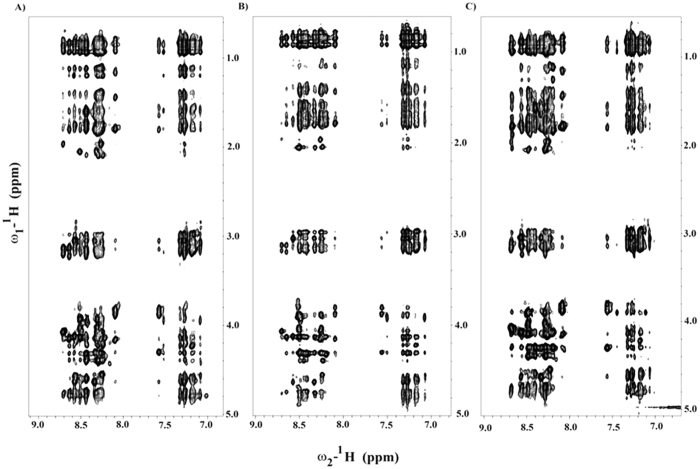
Selected sections of 1H-1H two-dimensional tr-NOESY spectra, obtained in the presence of LPS micelles, of piscidin-1 (panel A), T15,21K-piscidin-1 (panel B) and T15, 21dK-piscidin-1 (panel C) showing NOEs among low-field shifted amide and aromatic ring protons (along w2 dimension) with up-field shifted aliphatic protons (along w1 dimension).